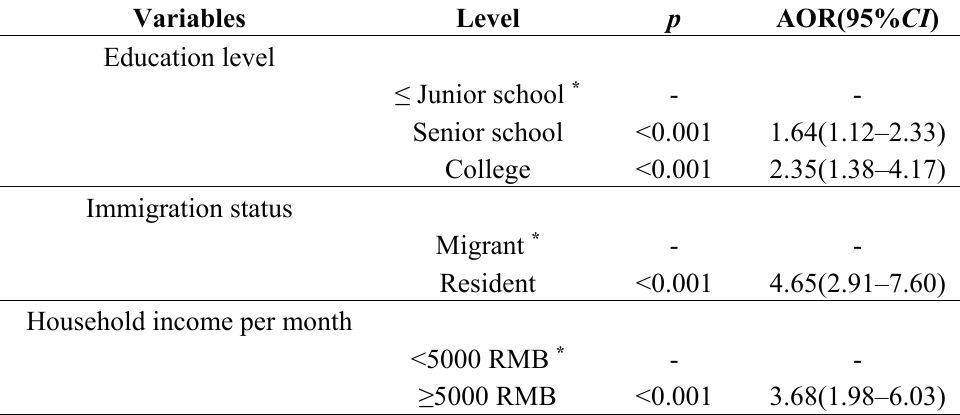
Table 5. Multivariate analysis for caregivers’ baseline vaccination knowledge